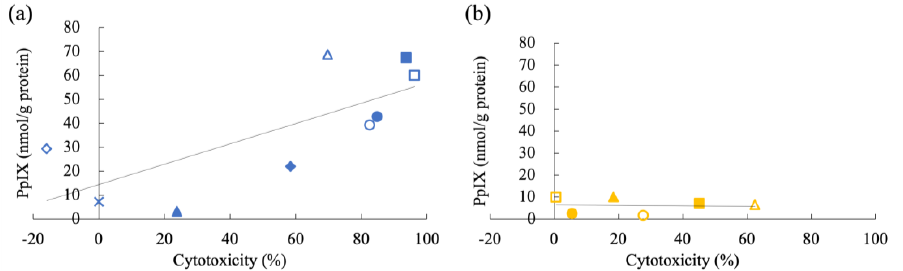
Figure 8. Relationship between the effects of photodynamic therapy (PDT) and the intracellular PpIX concentration in carcinomas ( a ) and sarcomas ( b ). Carcinomas: IUT (blue closed circle), Jack (blue open circle), Gal (blue closed triangle), YDP (blue open triangle), HDC (blue closed diamond), LuBi (blue open diamond), JDM (blue closed square), FBC (blue open square), and SNP (blue cross); Sarcomas: SGR (orange closed circle), KLC (orange open circle), DML (orange closed triangle), YCC (orange open triangle), ITP (orange closed square), and HTR (orange open square). Correlation of 5-ALA-PDT cytotoxicity at 1 mM with intracellular PpIX concentration was determined using Pearson correlation analysis.